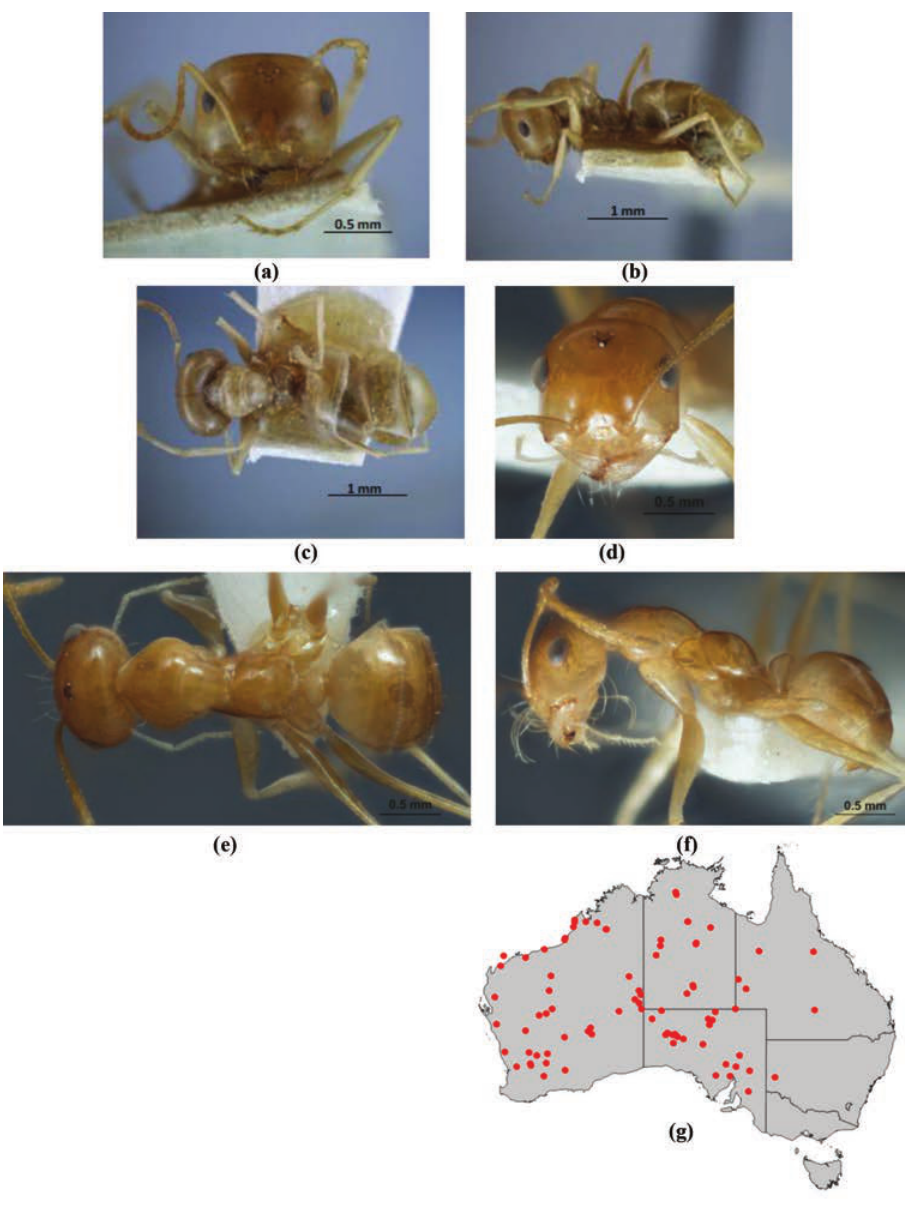
Figure 72. Melophorus sulla Forel: MCZ major worker syntype (CASENT090917) frons ( a ), profile ( b ) and dorsum ( c ); non-type minor worker (ANIC: 50 km S Coober Pedy, SA, 2 Oct. 1981, D. Davidson/S. Mor- ton, 69, (bottom ant) frons ( d ), profile ( e ) and dorsum ( f ); distribution map for the species ( g